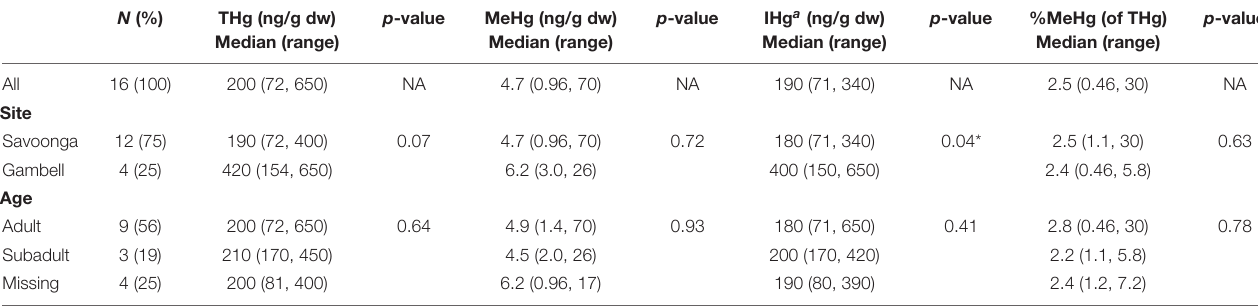
TABLE 1 | Associations between walrus characteristics and mercury concentrations in fecal samples ( n = 16 walruses). N (%)